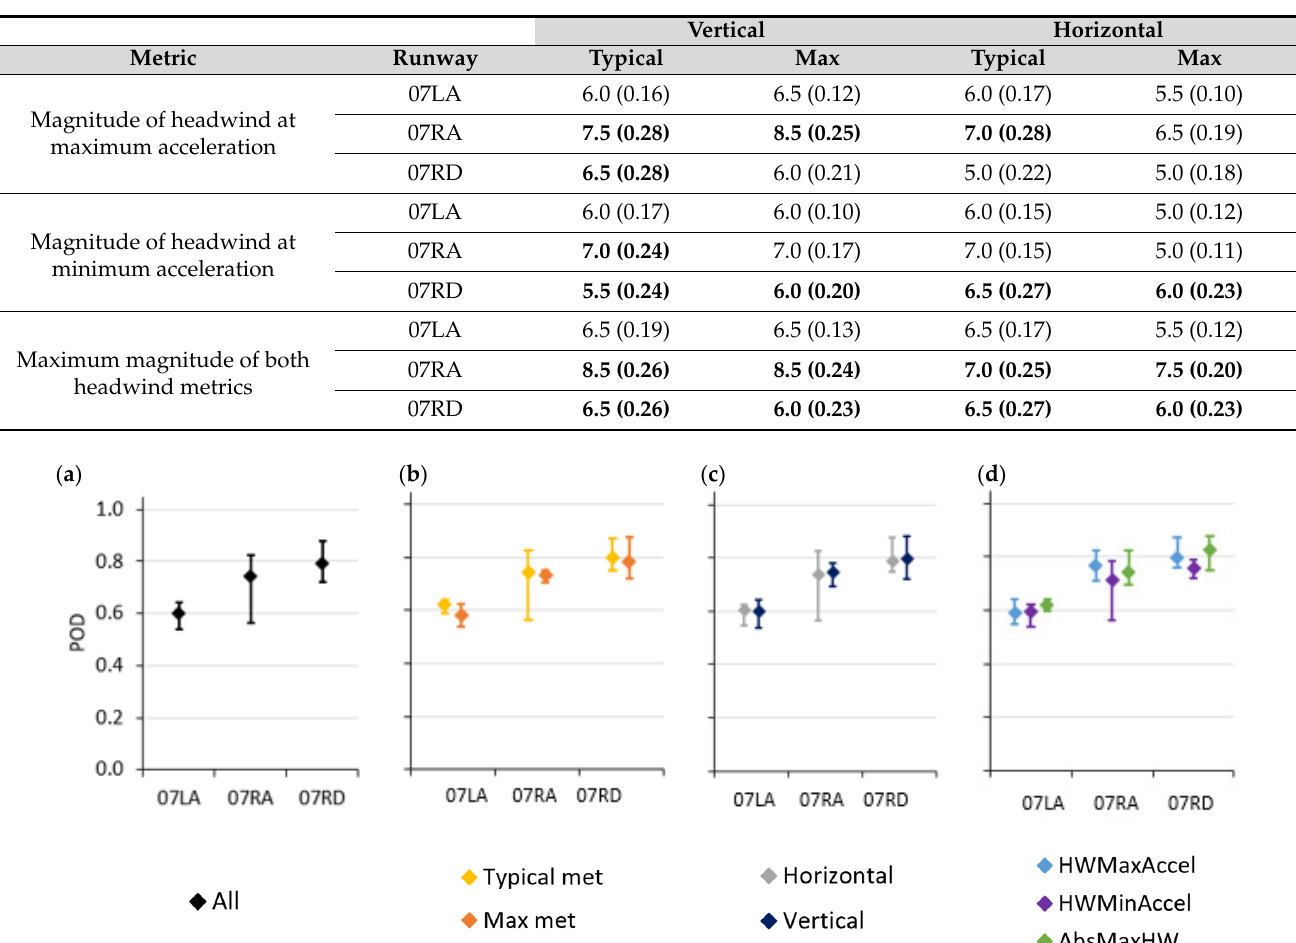
Table 6. Resultant wind-speed (m/s) thresholds calculated from the ROC-curve analysis. A quantita- tive indicator of performance is given in brackets for each scenario (with better performance indicated in bold, corresponding to POD × (1 − FAR) × (POD − FAR) > 0.2). Vertical Horizontal Metric Runway Typical